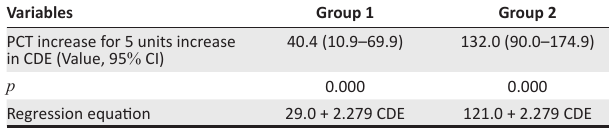
FIGURE 1: Fitted line plot between cumulative dissipated energy and difference in central corneal thickness post-operatively. TABLE 11: Linear regression prediction of peripheral corneal thickness increase according to cumulative dissipated energy used during phaco.